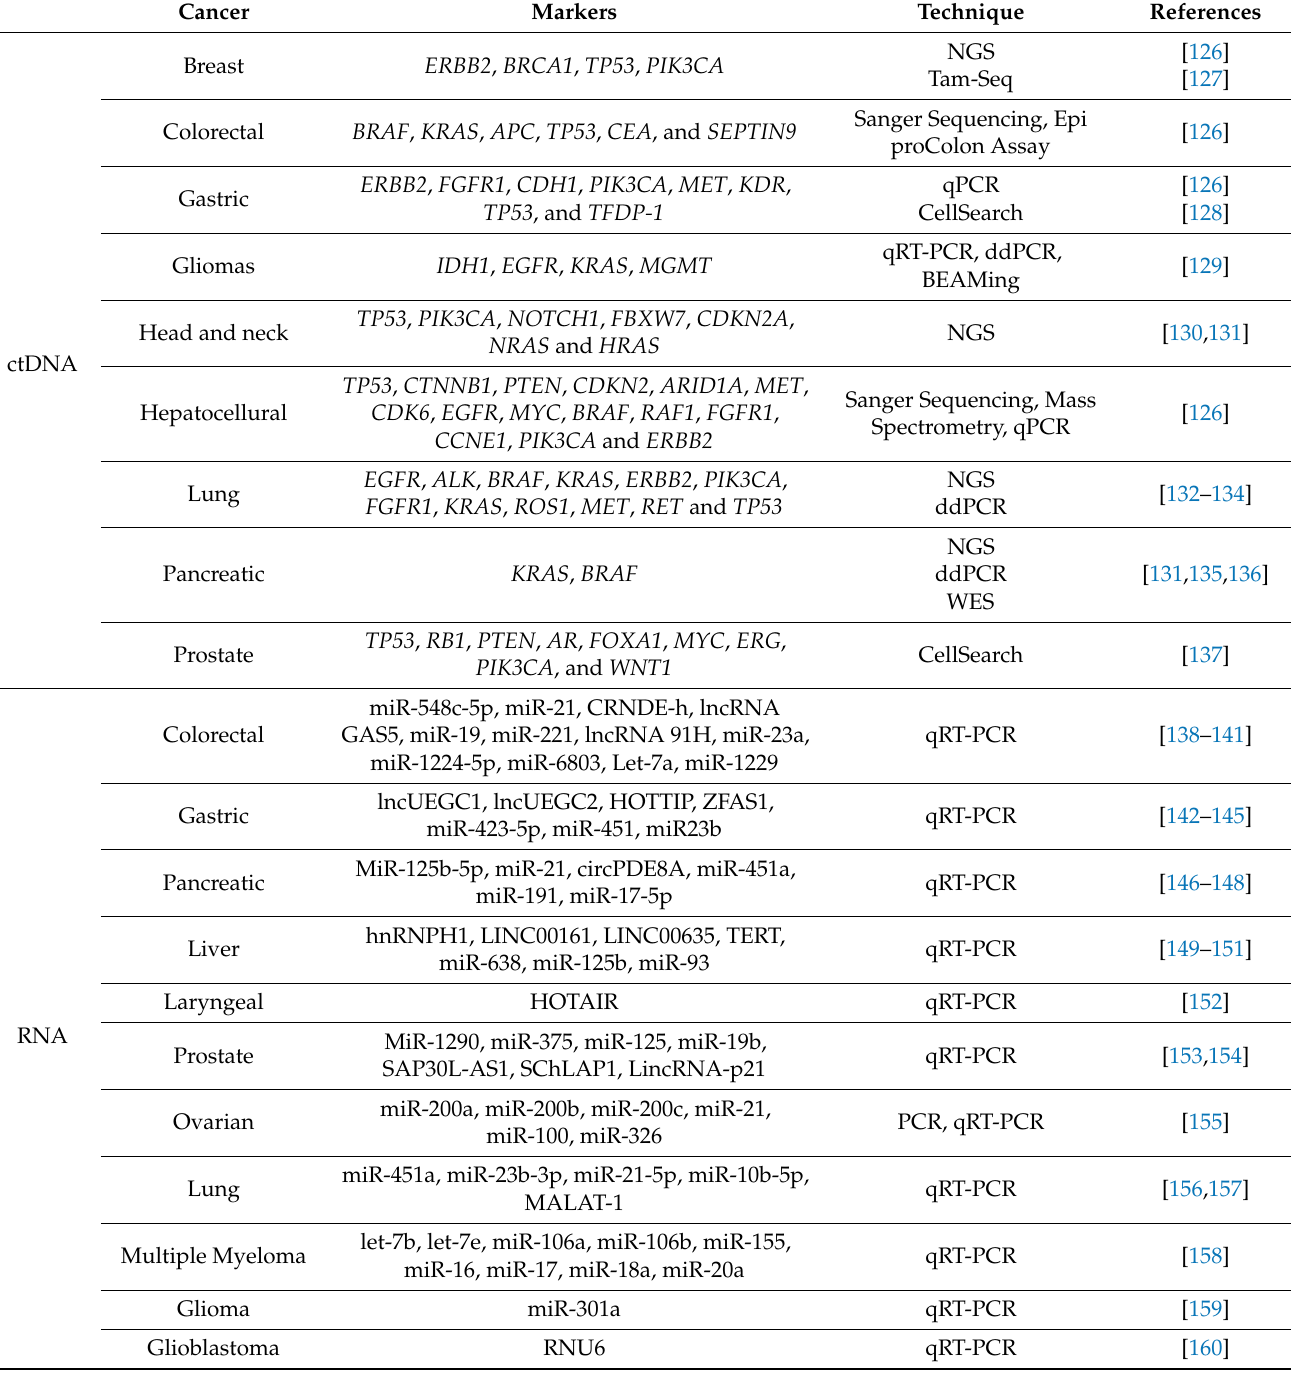
Table 2. Clinical applications of ctDNA, ctRNA and